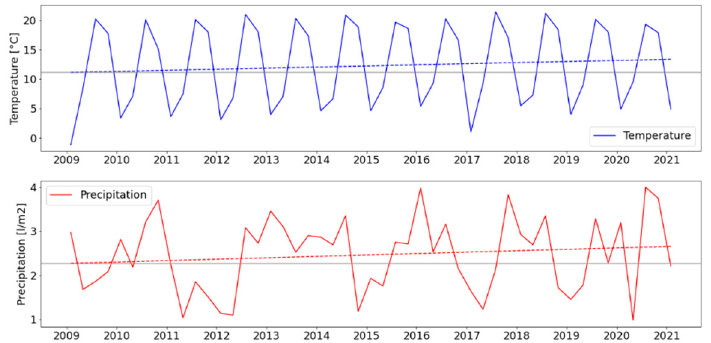
Figure 4. An overview of temperature and precipitation in Zagreb, Croatia through the studied timeframe 2009–2020. The data is plotted as a 3-month average and given trend-line by means of a regression line. The grey horizontal lines are the minimal values in of the regression line, showing the deviation from the minimal value.